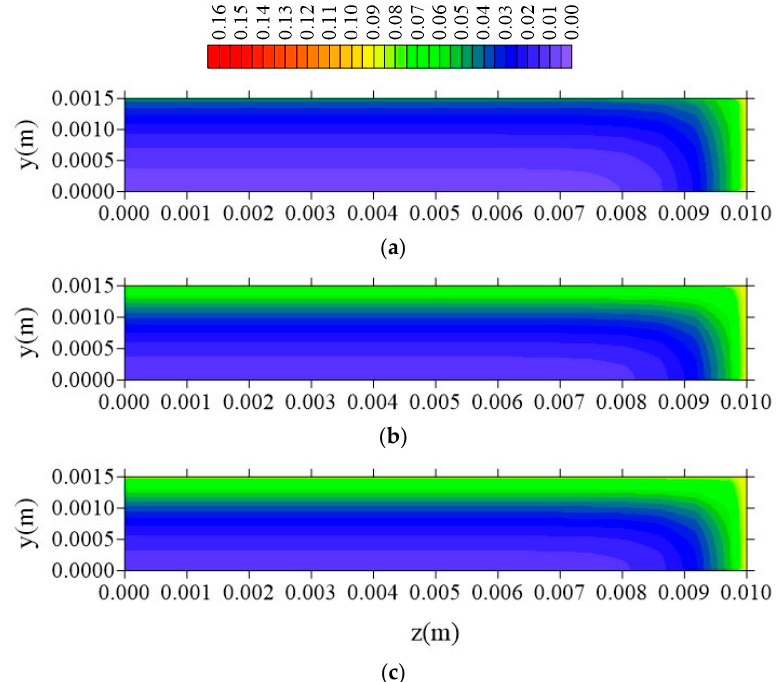
Figure 27. Distribution of entrapped solute concentration (S in kg / kg) in plan x = R x / 2 for di ff erent distances l y (t = 211 h, Cases 9, 11, and 12). In which ( a ) l y = 0.001 m; l x = 0.1 m and l z = 0.1 m; ( b ) l y = 0.01 m; l x = 0.1 m and l z = 0.1 m; ( c ) l y = 0.1 m; l x = 0.1 m and l z = 0.1